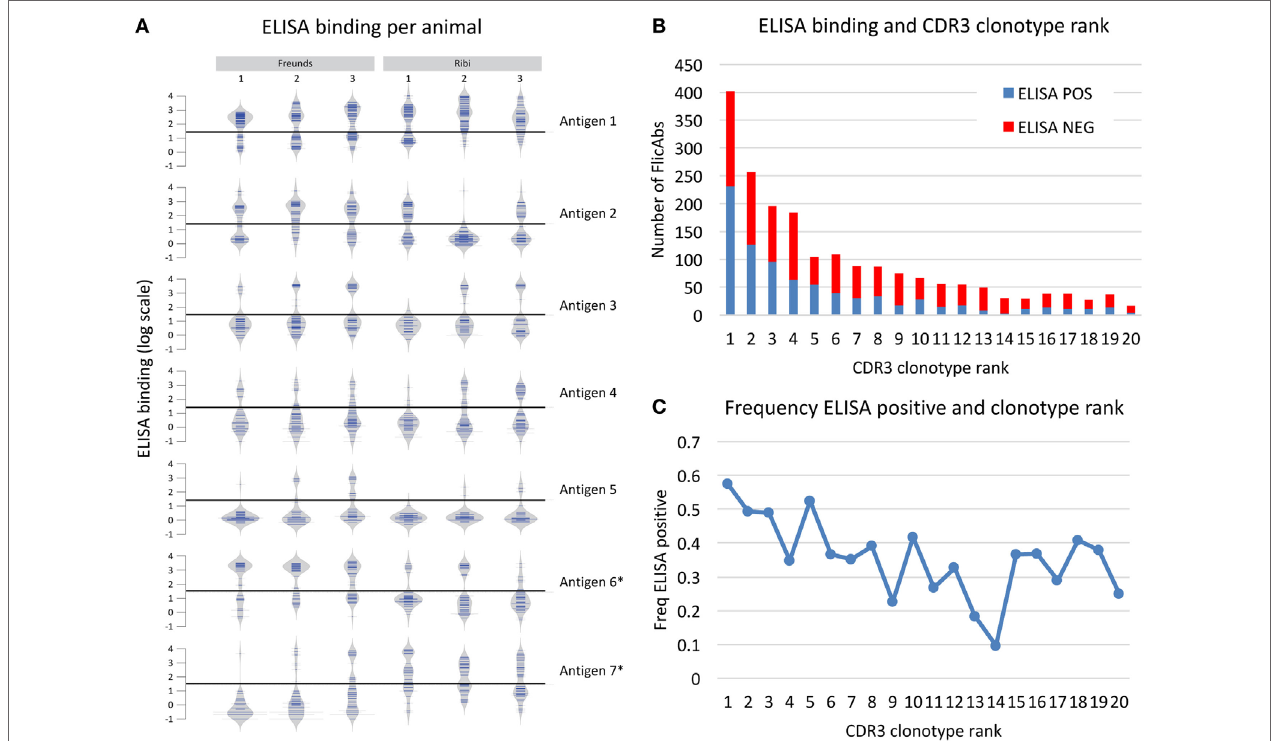
FigUre 4 | Antigen binding measured for 2,560 monoclonal FlicAbs. (a) Individual bean plots show the distribution of antigen-binding signal for 42 representative animals (6 animals immunized with 7 different antigens). The y -axis shows log transformed ELISA binding signal (fold-over background), and the horizontal line marks the threshold used for calling a FlicAb antigen positive or negative. The left three vertical columns are animals immunized with Freund’s adjuvant, and the right three columns are animals immunized with Ribi adjuvant. Each row is a different antigen. (B) The distribution of clonotype abundance (CDR3 clonotype rank) of the FlicAbs tested are shown as stacked bars where the red bar indicates ELISA negative FlicAbs and the blue indicates ELISA-positive FlicAbs. The y -axis indicates total FlicAb counts, and the x -axis category designates the abundance rank of the CDR3 clonotype. (c) The frequency of ELISA-positive FlicAbs categorized by abundance rank is shown. The y -axis indicates the frequency of ELISA positive, and the x -axis category designates the abundance rank of the CDR3